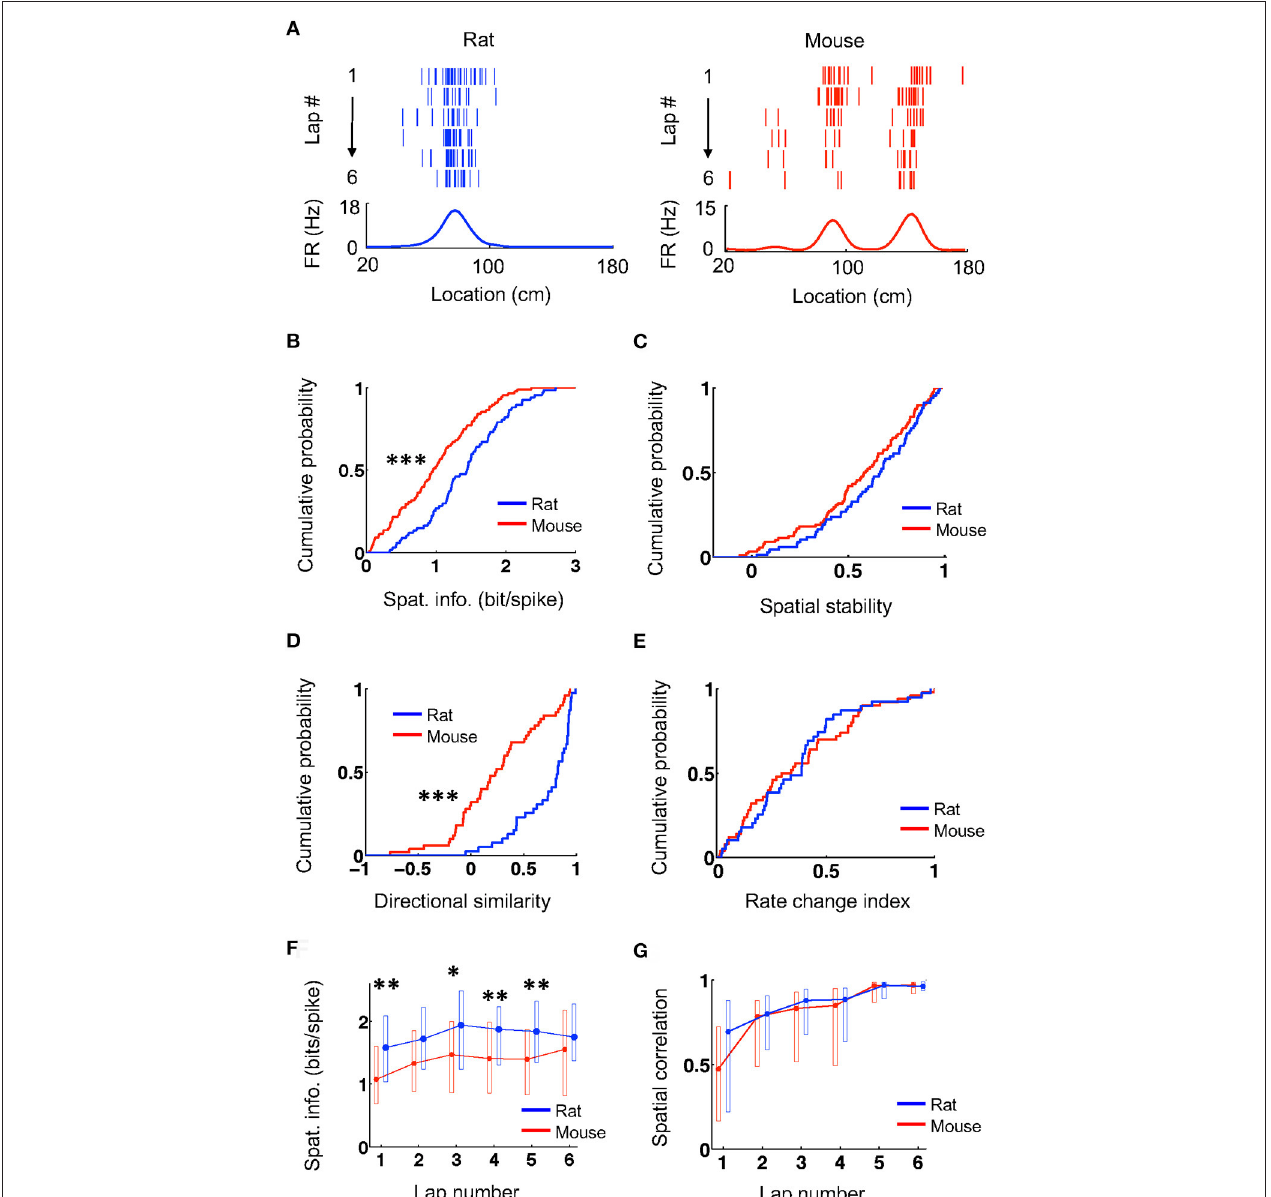
FIGURE 1 | Mouse place cells had lower spatial information than rat ones. (A) Firing activities of an example rat place cell and an example mouse place cell during running on a novel track trajectory. For each panel, the top shows lap-by-lap spike raster during the first 6 laps on a linearized trajectory (running direction: from left to right). Each row is a lap and each tick is a spike. The bottom trace is the firing rate curve averaged over all 6 laps. (B,C) Cumulative distributions of spatial information (B) and spatial stability (C) for rat and mouse place cells on the novel track. *** P < 0.001. (D,E) Cumulative distributions of directional similarity (D) and rate change index (E) for rat and mouse place cells between the two running trajectories on the novel track. *** P < 0.001. (F,G) Lap-by-lap changes in spatial information (F) and in spatial correlation (G) between each lap’ rate curve and the average rate curve of the last two laps. The plots represent median and [25, 75%] range values. ** P < 0.01, * P < 0.05, Wilcoxon test; significance values adjusted for the multiple (6) comparisons.